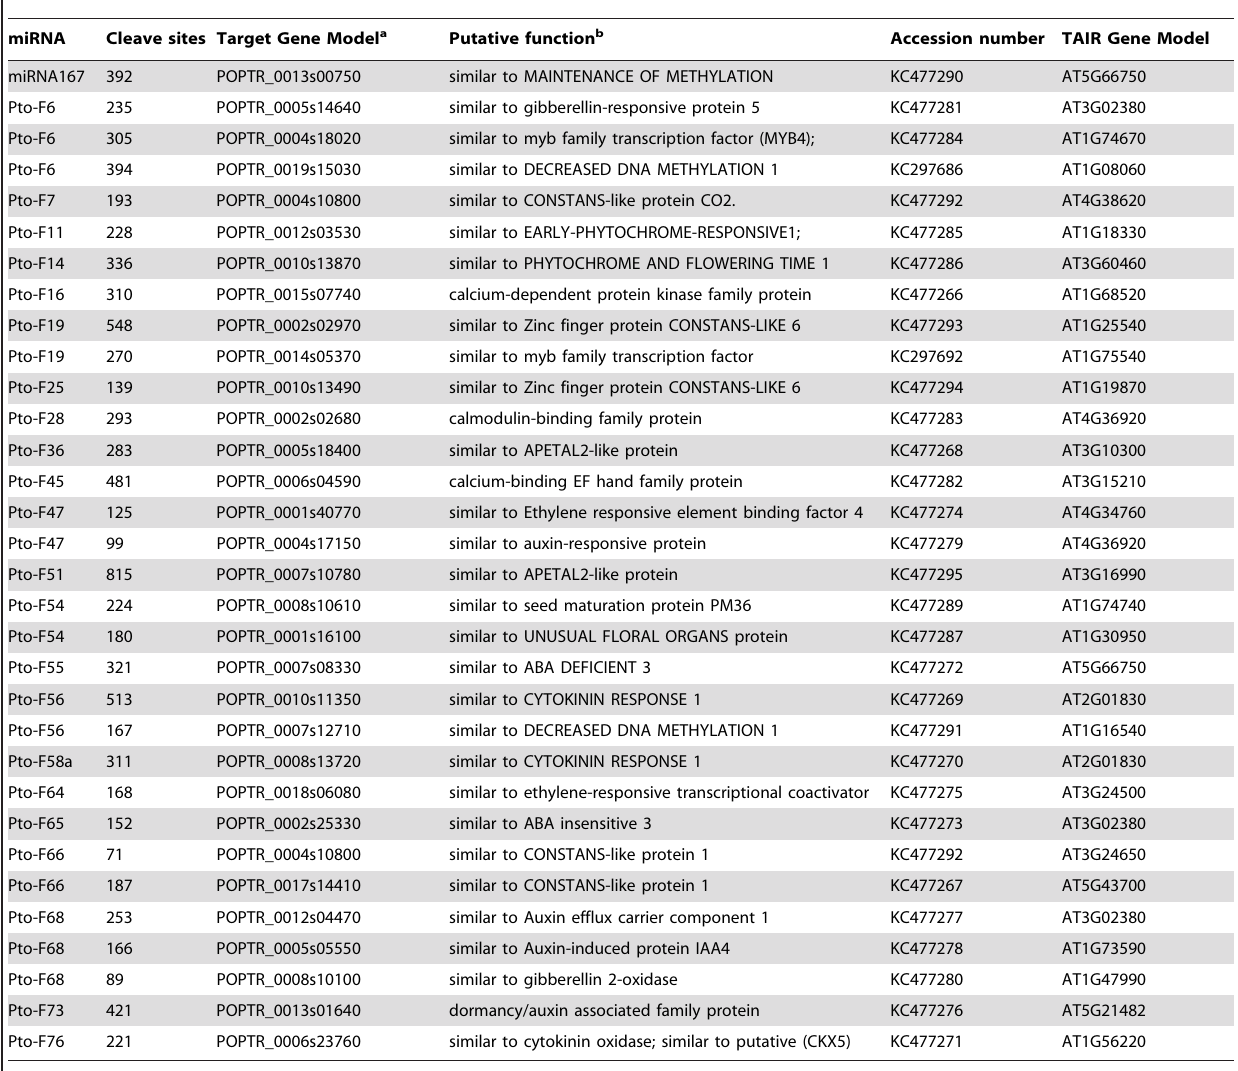
Table 7. Candidate targets of novel and conserved miRNAs in andromonoecious P. tomentosa .